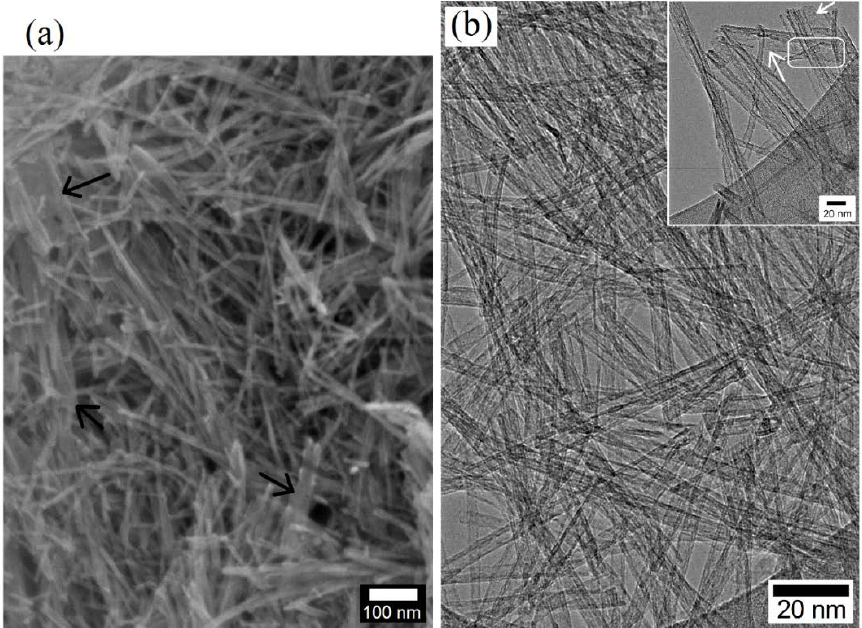
Figure 4. High magnification views of TiO 2 hybrid nanostructures (HN) produced via a hydrothermal process, indicating both sheet-like and tubular morphologies: ( a ) SEM micrograph and ( b ) TEM microstructures with inset showing nanotubes (white arrows) and nanosheet (enclosed area).